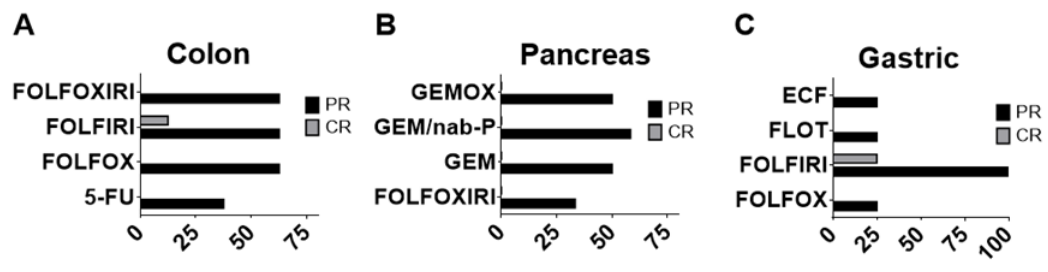
Figure 9. Percentage of partial response (PR) and complete response (CR). FOLFOXIRI, FOLFIRI, FOLFOX and 5-FU treatments in zebrafish avatars xenotransplanted with colon tumor ( n = 8 patient samples analyzed) ( A ); GEMOX, GEM / nab-P, GEM, FOLFOXIRI treatments in zebrafish avatars xenotransplanted with pancreas tumor ( n = 12 patient samples analyzed) ( B ); ECF, FLOT, FOLFIRI and FOLFOX treatments in zebrafish avatars xenotransplanted with gastric tumor ( n = 4 patient samples analyzed) ( C ).